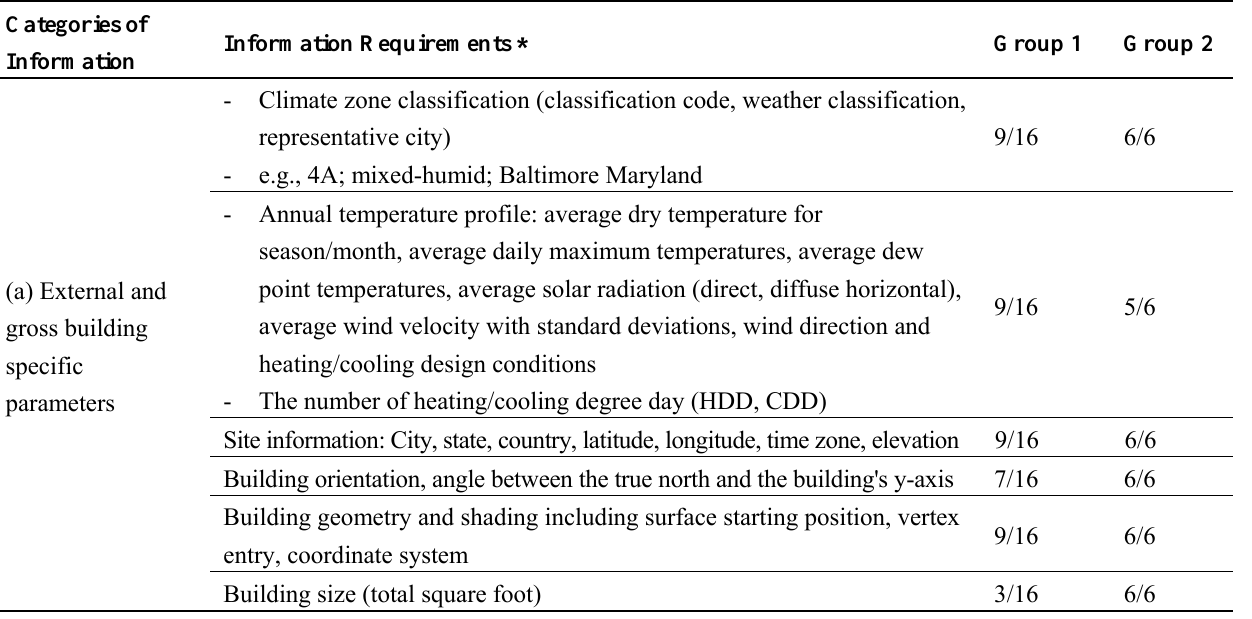
Table 4. Information requirements of IDG members to be conveyed in immersive settings during design review